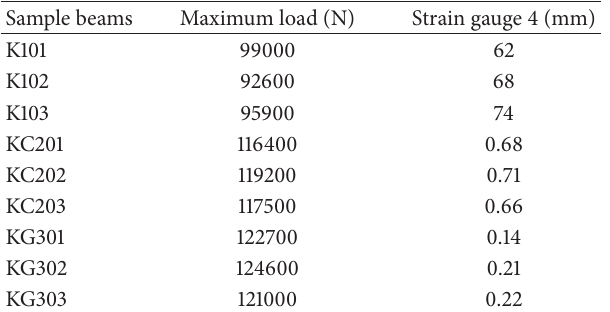
Table 7: Flexural cracks against the maximum load in sample